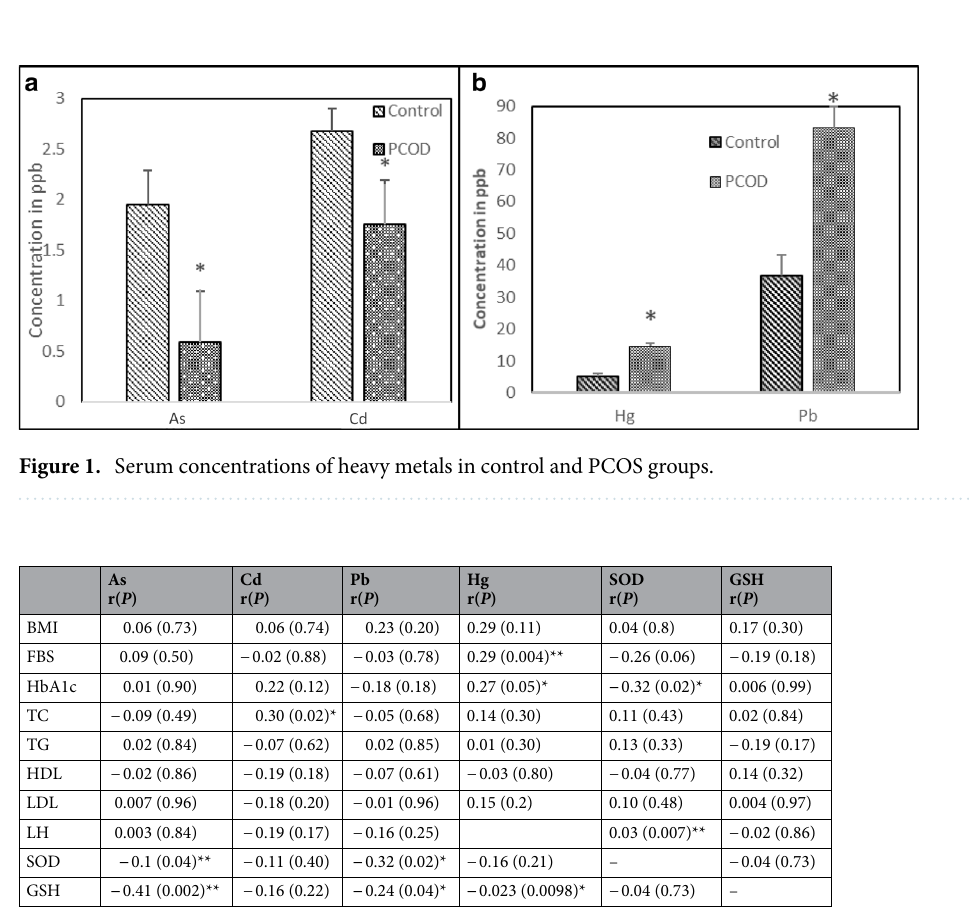
Table 3. Correlation coefficients among the oxidative stress markers, metabolic markers and heavy metals in the PCOS group. * p ≤ 0.05; ** p ≤